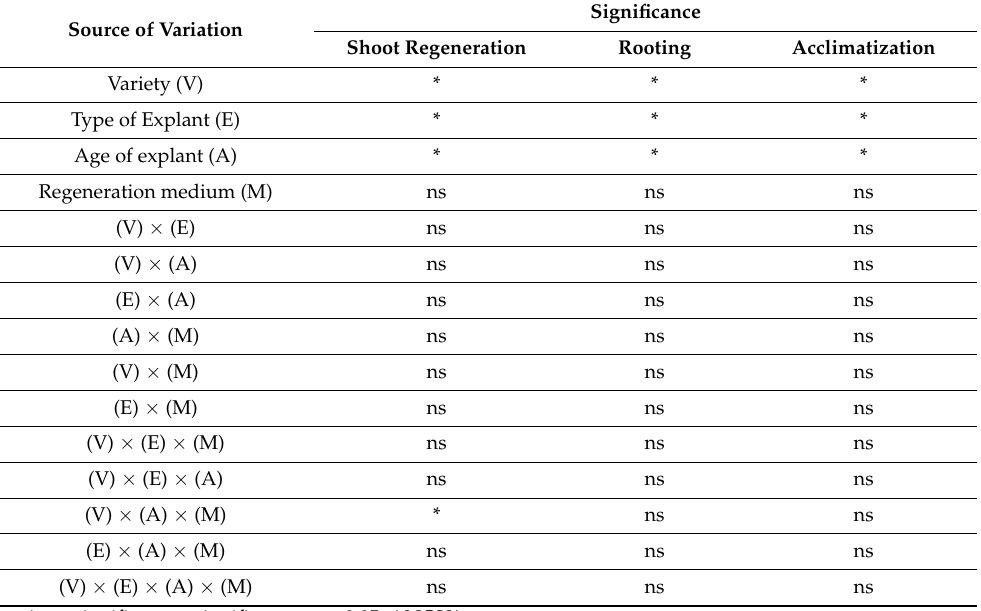
Table 1. ANOVA results regarding sources of variation and their interactions for shoot regeneration, rooting, and acclimatization.